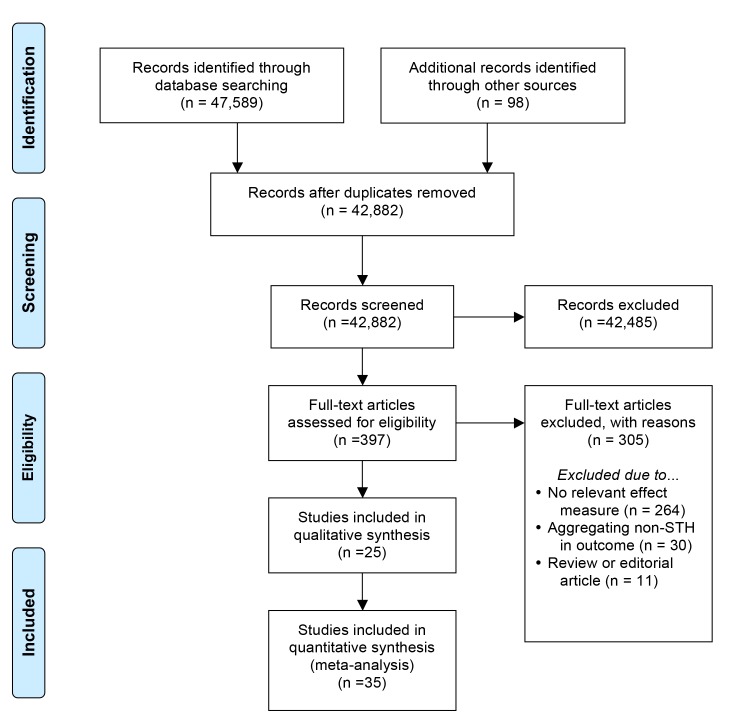
PRISMA flow diagram.